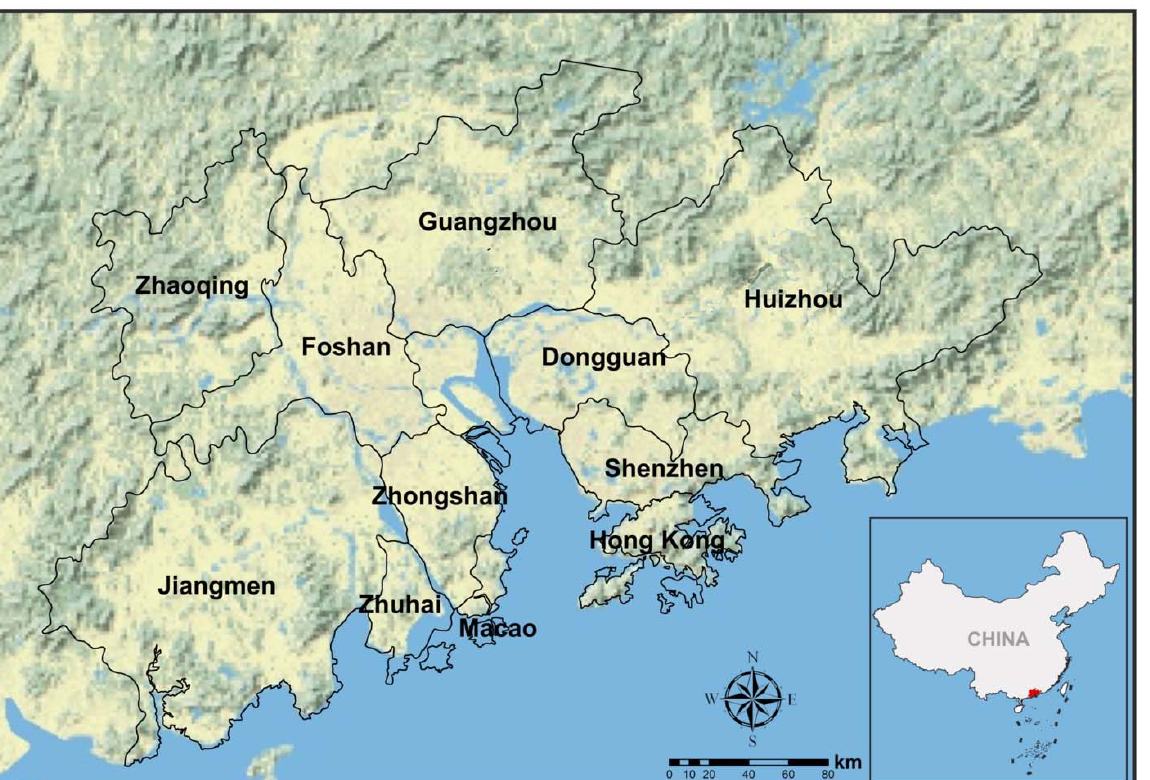
Figure 2. The framework for integrating MSPA and habitat availability indices for evaluating re ‐ gional urban heat islands. Red “X” means block or destroy the connectivity of the result to allevi ‐ ate the regional surface UHI effect.